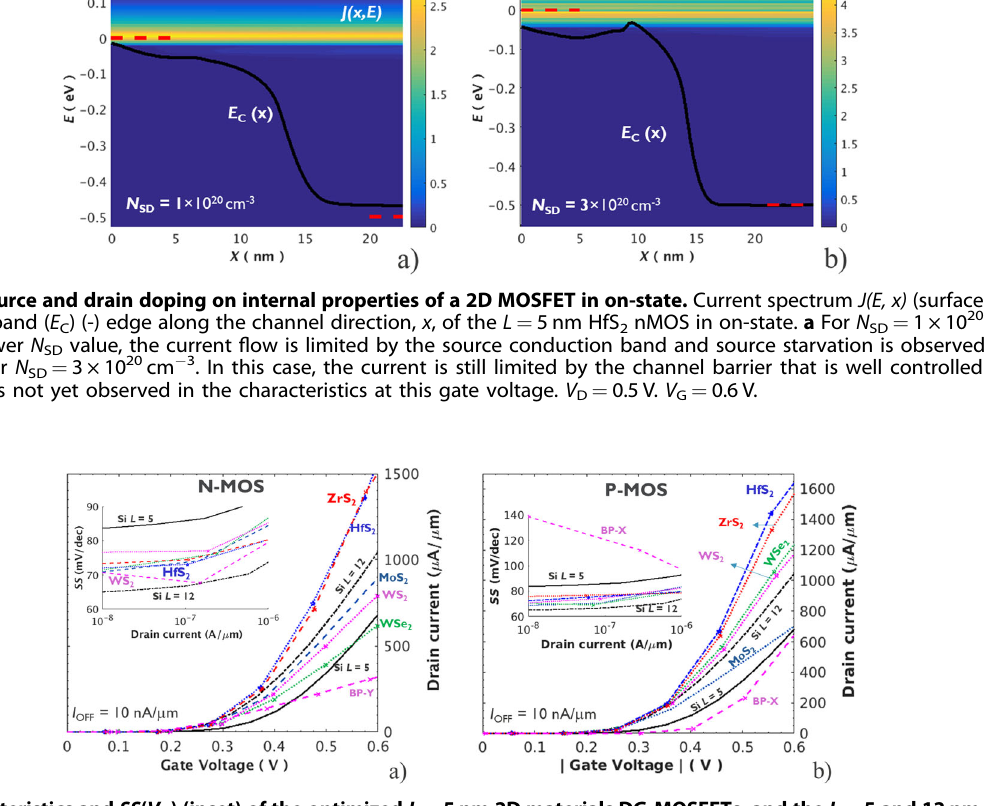
Fig. 8 I D ( V G ) characteristics and SS ( V G ) (inset) of the optimized L = 5 nm 2D materials DG-MOSFETs, and the L = 5 and 12 nm Si optimized GAA. a n- and b pMOS transistors. | V D | = 0.6 V. I OFF = 10 nA/ μ m. e-ph scattering is included. The devices are optimized in terms of source- and drain-doping concentration ( N SD ), channel orientation (if anisotropic) and thickness ( t S ) for the GAA. HfS 2 and ZrS 2 IV ’ s are shown along the Γ K channel orientation. The current is normalized by the gate perimeter.